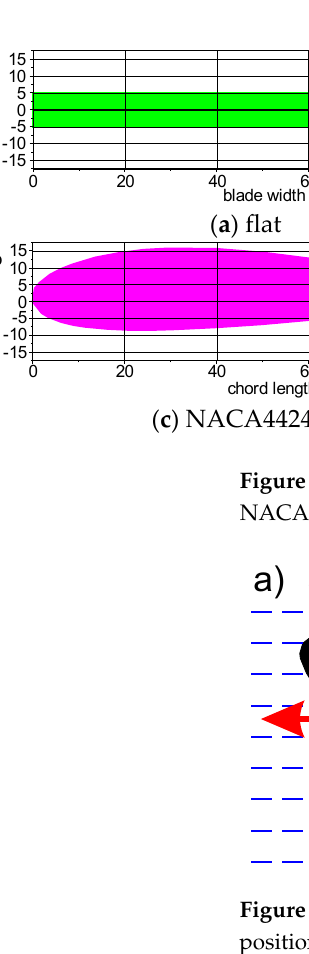
Figure 4. Positioning of asymmetrical profile. ( a ) normal profile setting as in airplane wing ( b ) reverse positioning of the profile (upside down) ( c ) setting equivalent to setting ( b ).